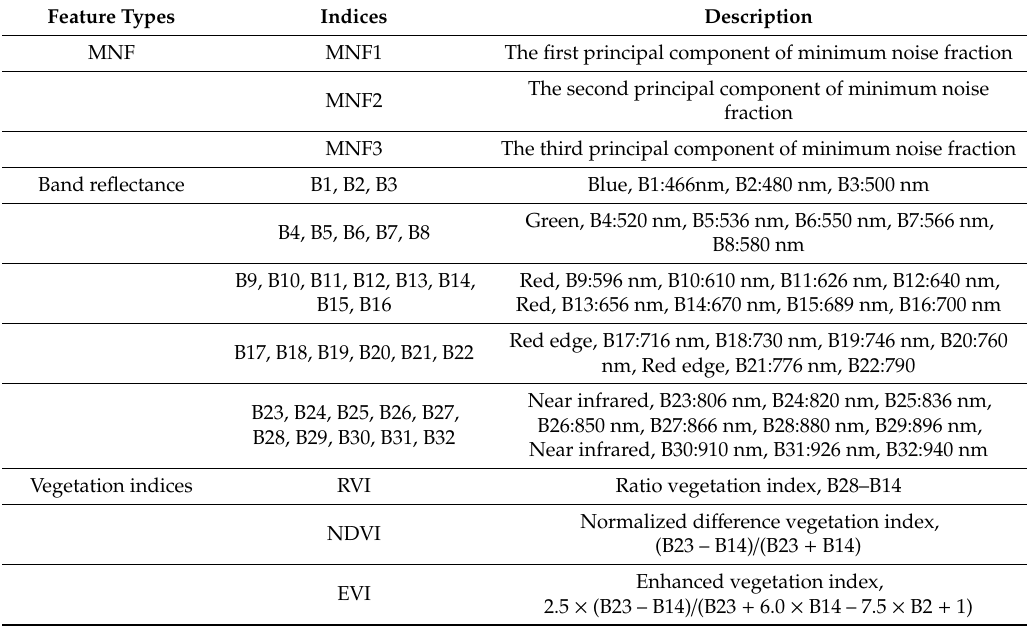
Table 2. Remote sensing indices from OHS-1 hyperspectral data for features extraction.